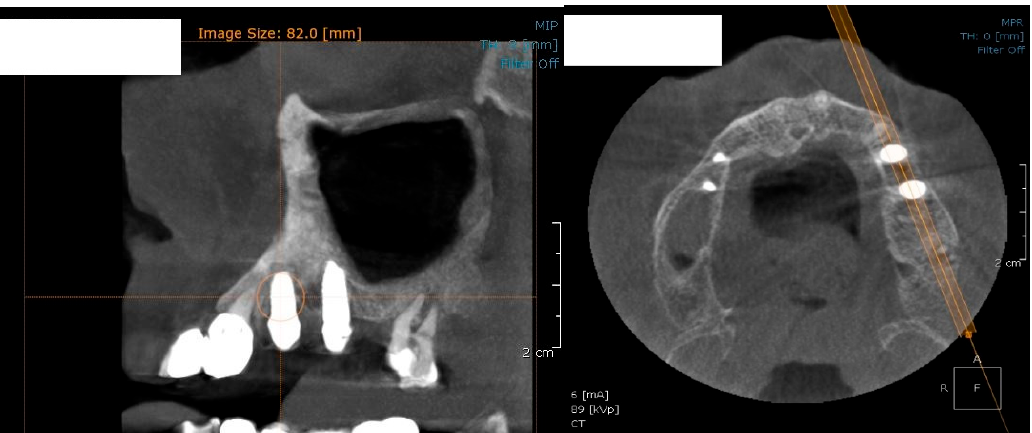
Figure 1. The field of view was a cylinder of 82 mm in diameter and height. The left panel is a 3D section CBCTCone Beam Computed Tomography image, whereas the right panel represents an oblique-section of the same image. F, frontal view, A, Axial View, R, right side view.